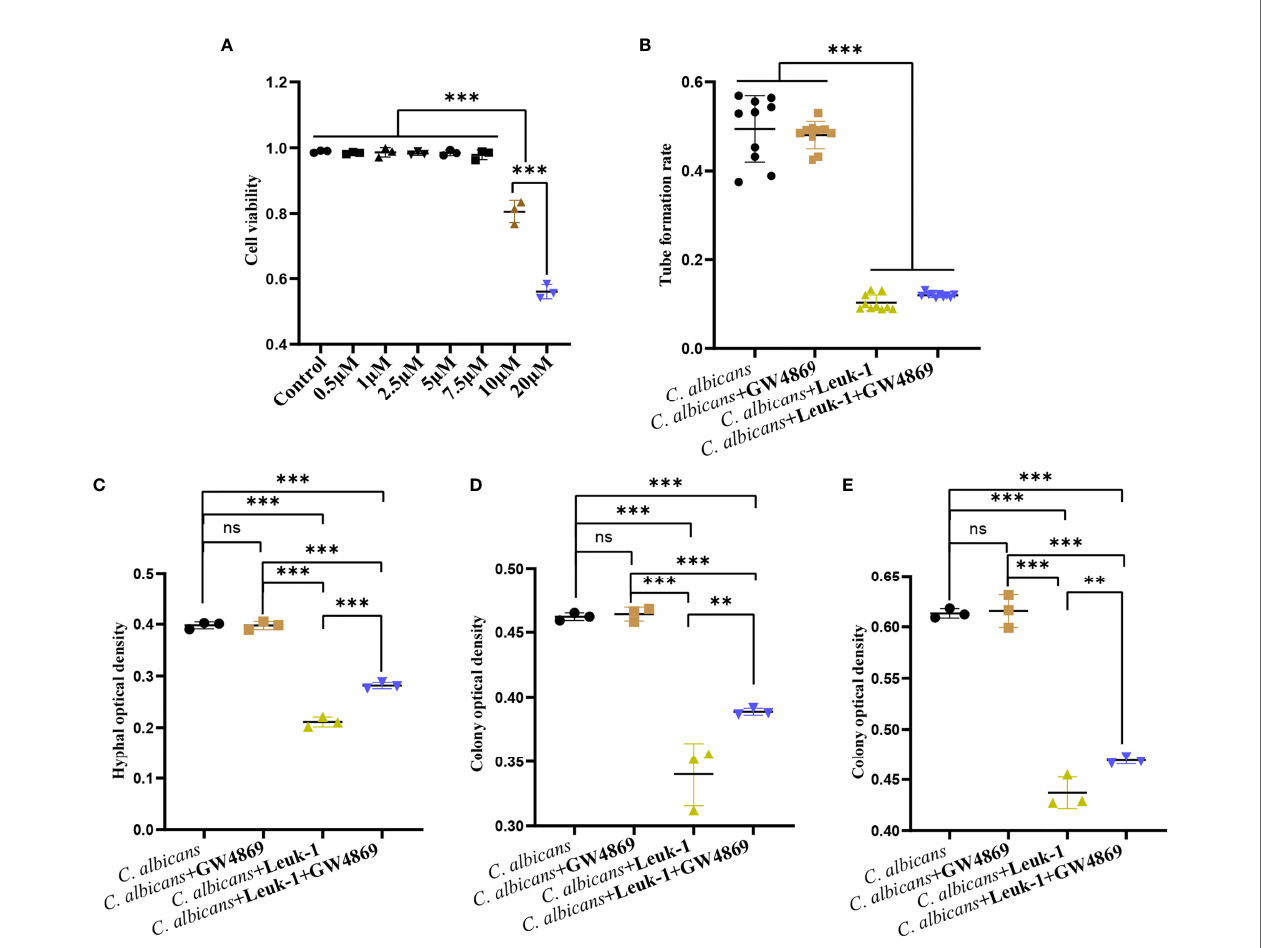
FIGURE 6 | GW4869 attenuated the inhibitory effects of Leuk-1 cells on C. albicans . (A) Cell viability of Leuk-1 cells after treatment with varying concentrations of GW4869. (B) Changes in the germ tubes of different groups at 2 h (n = 10). (C) Changes in the hyphal percentages of different groups at 12 h (n = 3). (D) Changes in the microcolony optical densities of different groups at 24 h (n = 3). (E) Changes in the microcolony optical densities of different groups at 48h (n = 3). Statistical signi fi cance was tested by one-factor ANOVA. ns, not signi fi cant; **P < 0.01; ***P <